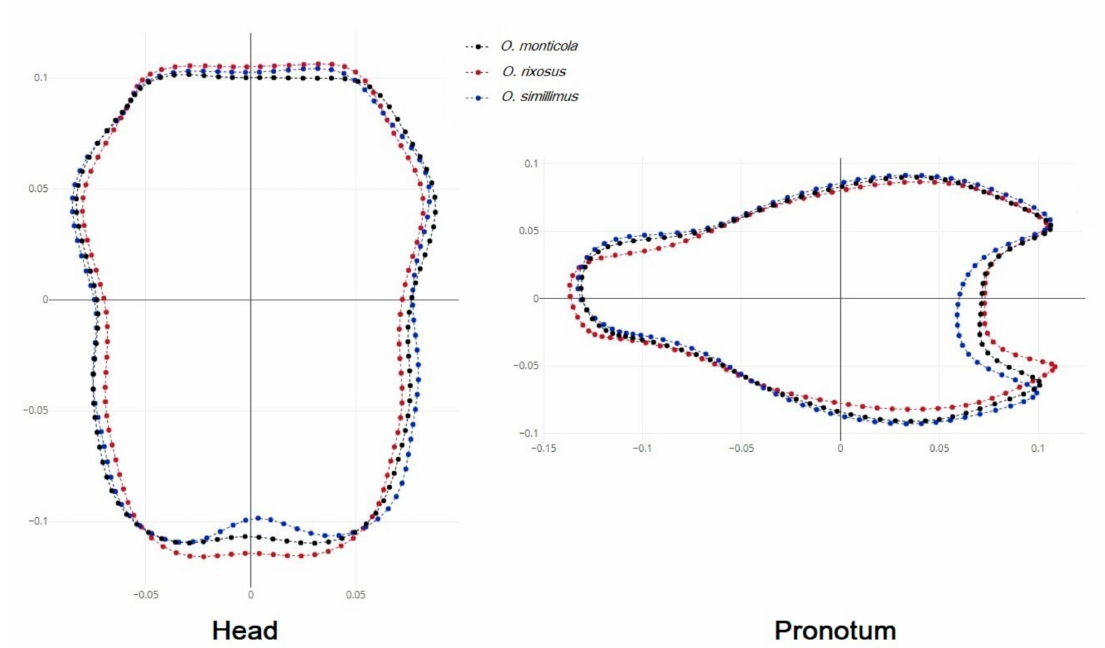
Figure 5. Superposition of mean shapes showing mean differences between O. monticola (black), O. rixosus (red), and O. simillimus (blue) for the head ( left ) and for the pronotum ( right )